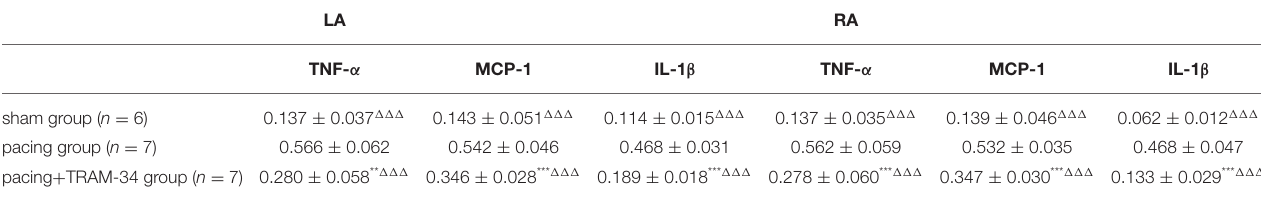
TABLE 2 | Levels of inflammatory cytokines in atrial tissue. LA RA TNF- α